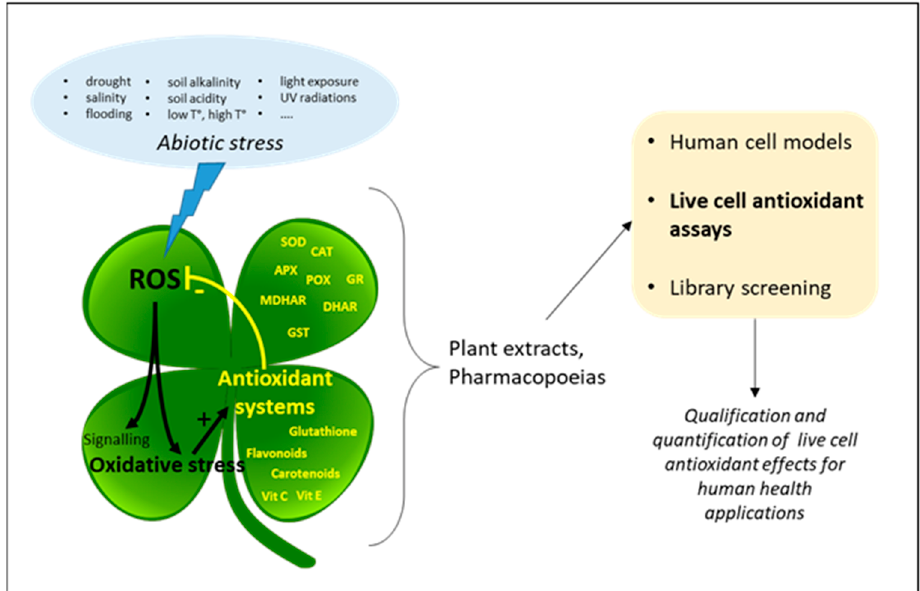
Figure 1. Strategy of valorization of plant extracts through live cell assays. Due to the strong environmental influence, plants produce oxidative stress, which forces them to equip themselves with powerful antioxidant systems. Emergence of new standardized live cell assays now allows for quantification of plant extract antioxidant power from monograph to high-throughput screening studies. SOD: superoxide dismutase; CAT: catalase; APX: ascorbate peroxidase; POX: peroxidases; GR: glutathione reductase; GPX: glutathione peroxidase; (M)DHAR: (mono)dehydroascorbate reductase; GST: glutathione- S -transferase.